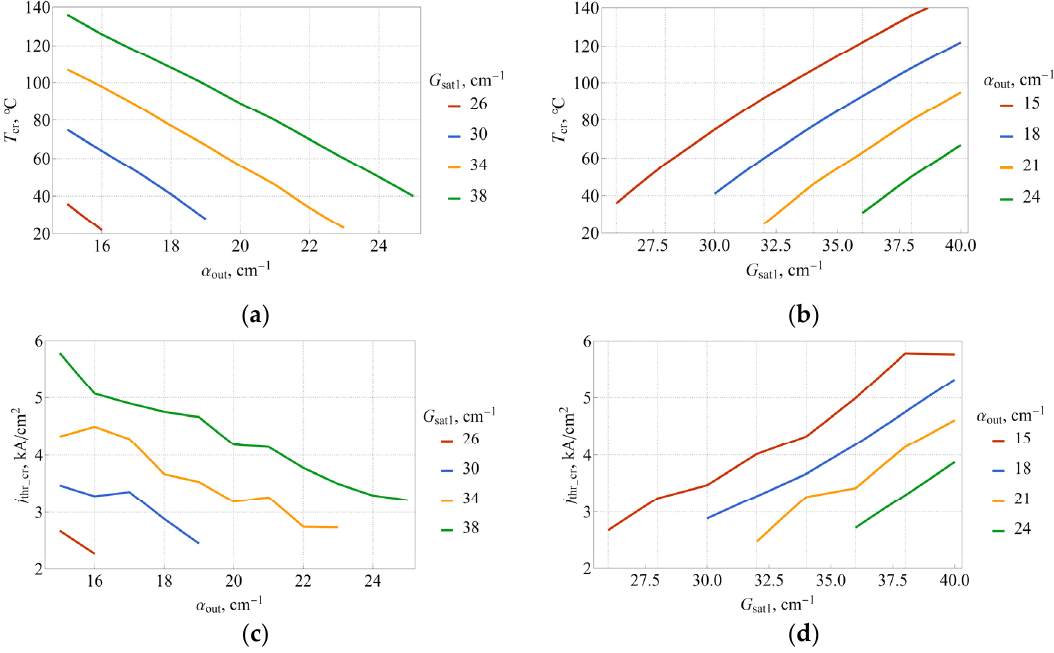
Figure 5. Critical temperature ( a , b ) and corresponding threshold current density ( c , d ) as a function of α out ( a , c ) and G sat 1 ( b , d